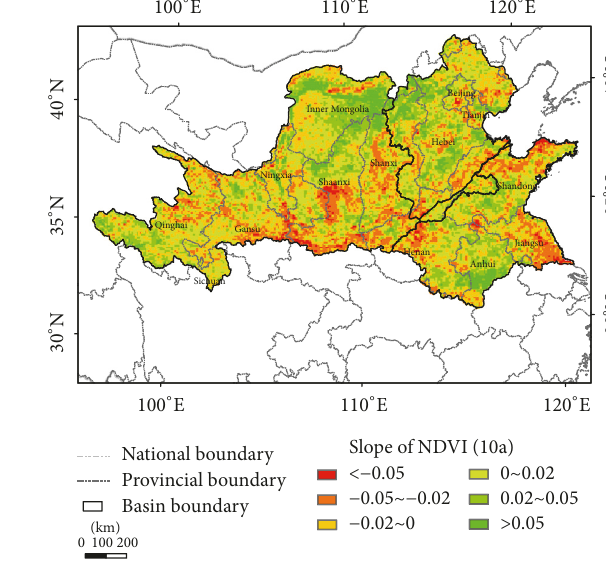
Figure 8: Rate of change in rainstorm days from 1982 to 2011.